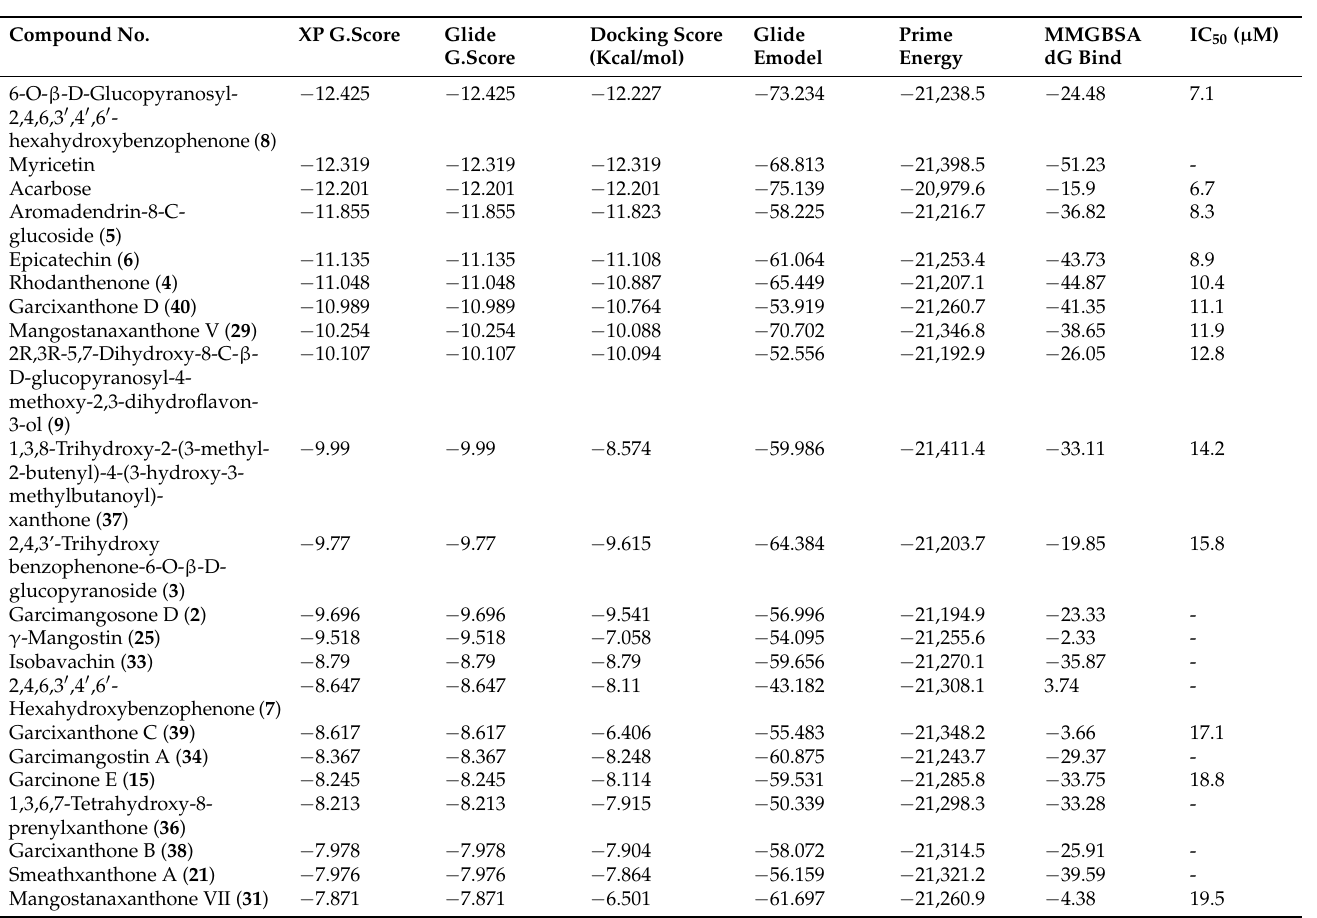
Results of in silico screening against alpha-amylase (PDB: 4GQR) and in vitro inhibition